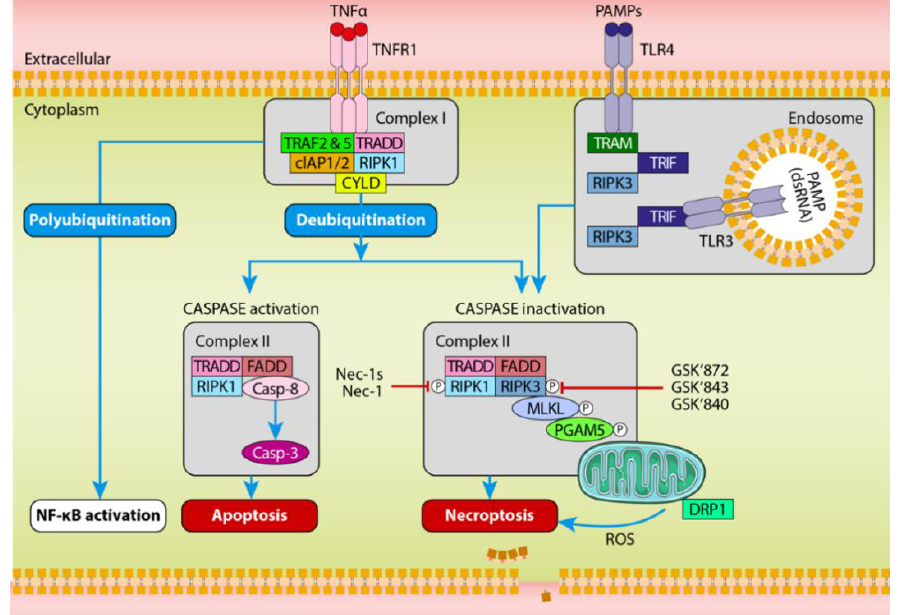
Figure 2. TNFα-induced cell death pathway. (a) TNFα stimulates TNFR1 to generate complex I by Figure 2. TNF α -induced cell death pathway. TNF α stimulates TNFR1 to generate complex I by recruiting TRADD, TRAF2 and 5, RIPK1 and cIAP1/2. Polyubiquitination of RIPK1 in complex I will recruiting TRADD, TRAF2 and 5, RIPK1 and cIAP1 / 2. Polyubiquitination of RIPK1 in complex